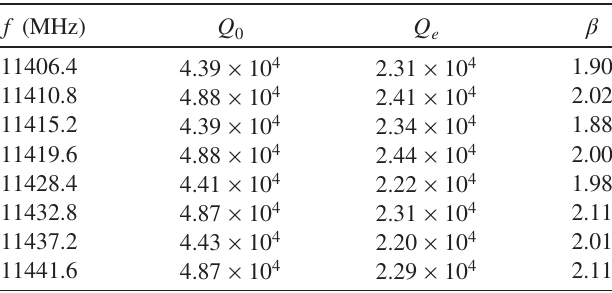
TABLE II. Q -factor and coupling factor of each mode in correction